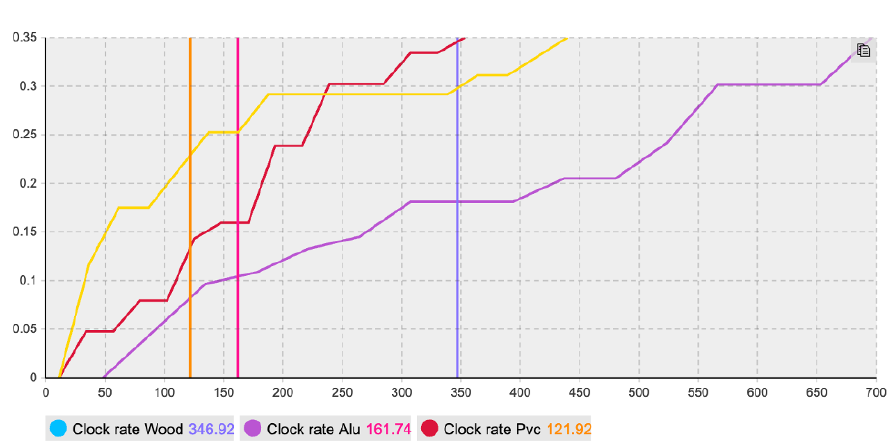
Figure 9. Time visualization of cycle times and clock rates of the produced frames according to their material, Software: